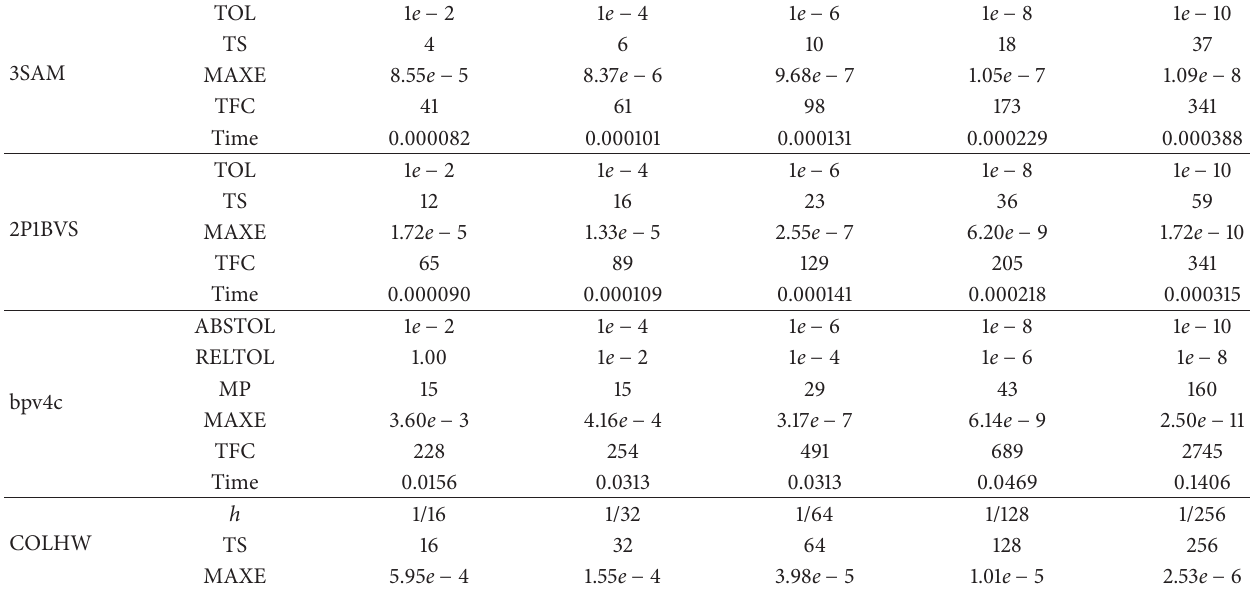
Table 2: Comparison of the numerical result for solving Problem